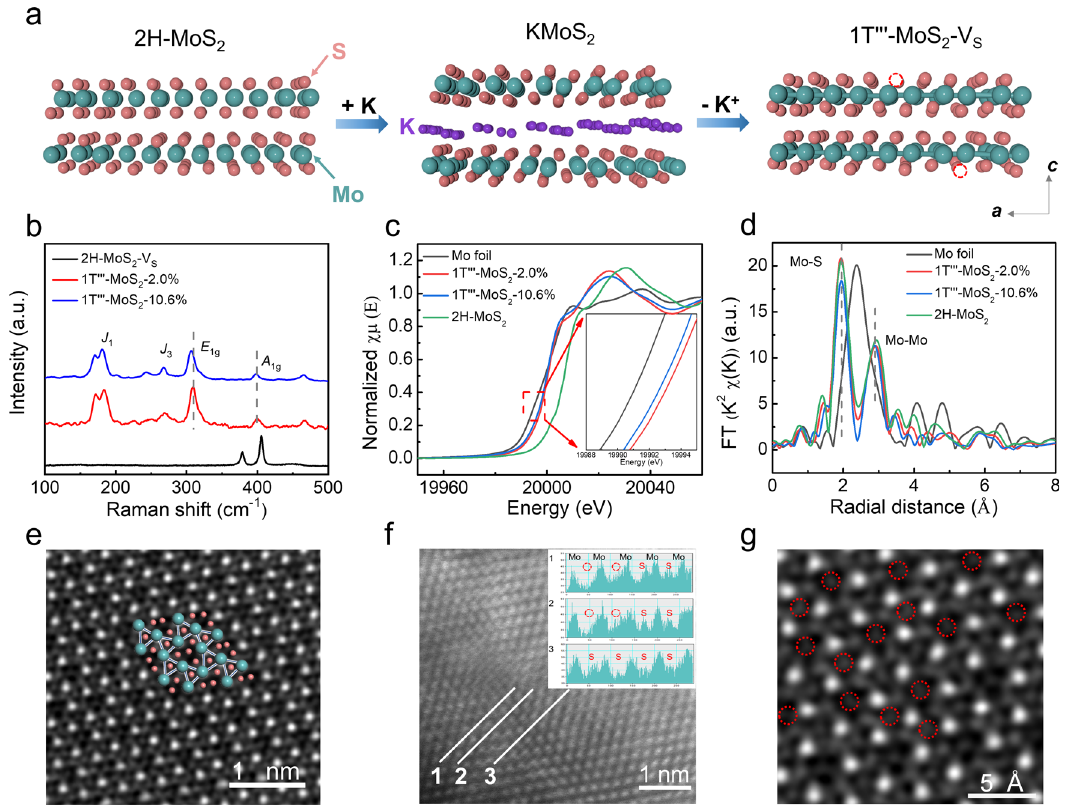
Fig.2|Characterizationsofstructureof1T'''-MoS 2 -V S .a Fabricationprocedureof 1T'''-MoS 2 -V S crystals synthesized by high temperature solid-state reactions for chemical insertion and wet chemical routes for K + extraction and S vacancies generation. b Ramanspectraof 2H-MoS 2 -V S , 1T'''-MoS 2 − 2.0%and 1T'''-MoS 2 − 10.6%. c Mo K-edge XANES spectra and ( d ) FT-EXAFS spectra of Mo foil, 2H-MoS 2 ,